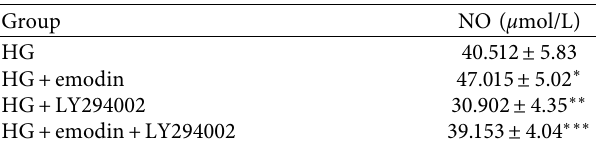
Table 2: Effect of emodin on culture supernatant NO content of